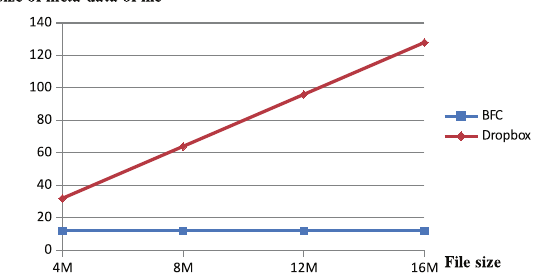
Fig. 13. Metadata comparison of BFC and